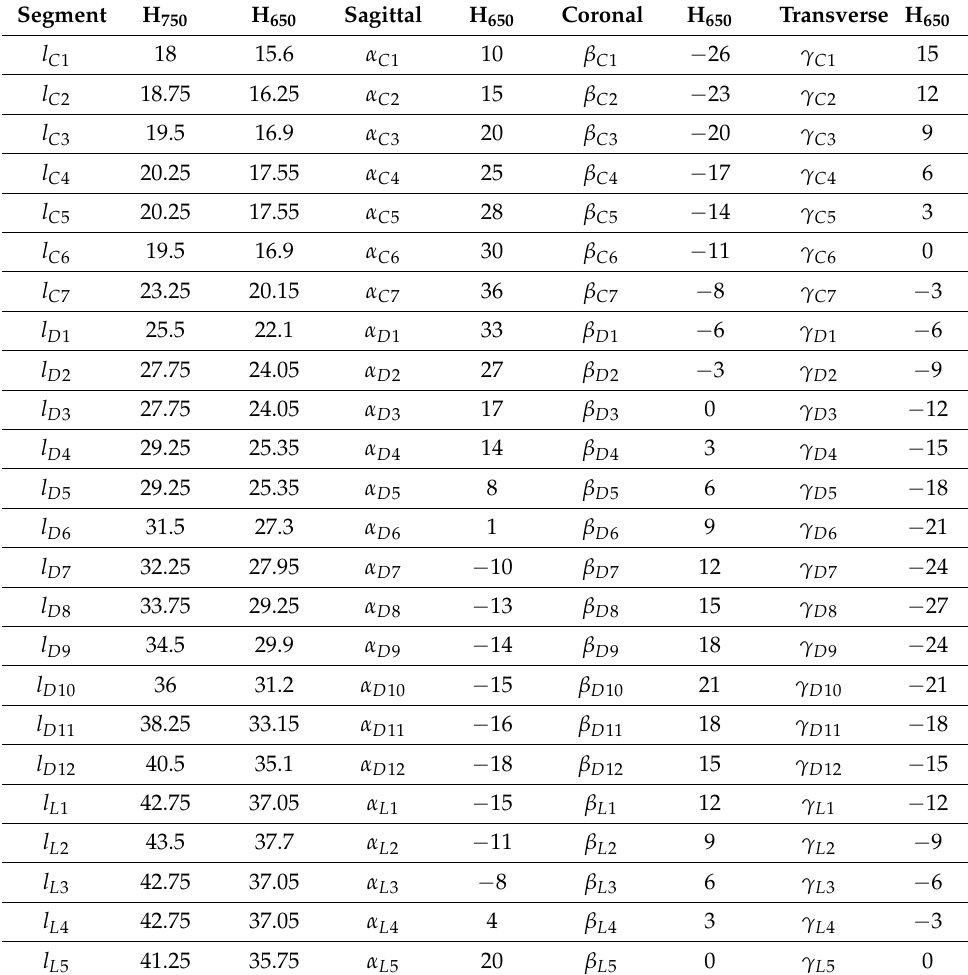
Figure 14. The trunk model in the 3D view; ( a ) front view ( b ) back view ( c ) and right lateral view ( d ). Table 1. Values of Ltn for the different values of the deformation angles,